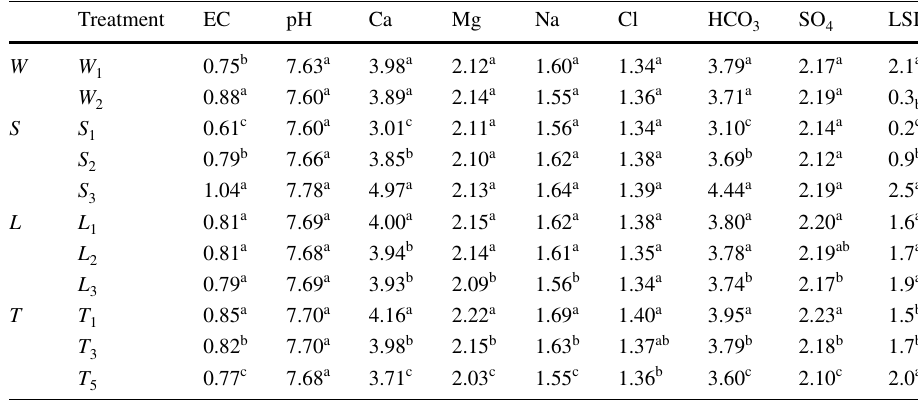
Each value in the table is an average of